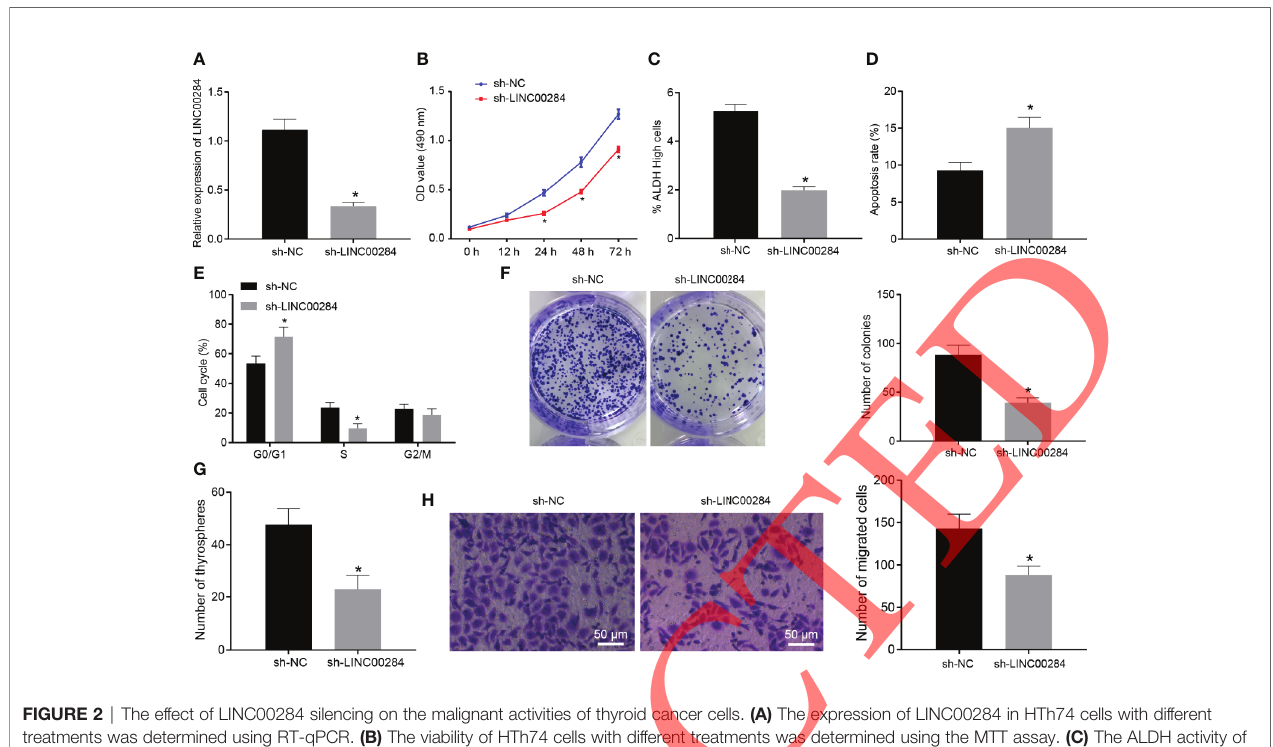
FIGURE 2 | The effect of LINC00284 silencing on the malignant activities of thyroid cancer cells. (A) The expression of LINC00284 in HTh74 cells with different treatments was determined using RT-qPCR. (B) The viability of HTh74 cells with different treatments was determined using the MTT assay. (C) The ALDH activity of HTh74 cells with different treatments was determined using the ALDEFLUOR assay. (D) Flow cytometry analysis of the cell cycle of HTh74 cells with different treatments. (E) Apoptosis of HTh74 cells with different treatments was determined using fl ow cytometry. (F) The colony formation ability of HTh74 cells with different treatments. (G) Self-renewal ability of HTh74 cells with different treatments was assessed using cell sphere formation assay. (H) The invasive ability of HTh74 cells with different treatments was assessed using Transwell assay. * p < 0.05 compared with the cells transfected with sh-NC. Data are presented as the means ± standard deviations. Comparisons between two groups were analyzed using the unpaired t -test, and comparisons among groups at different time points were analyzed using repeated measurement ANOVA with Tukey ’ s post hoc test. The experiments were repeated three